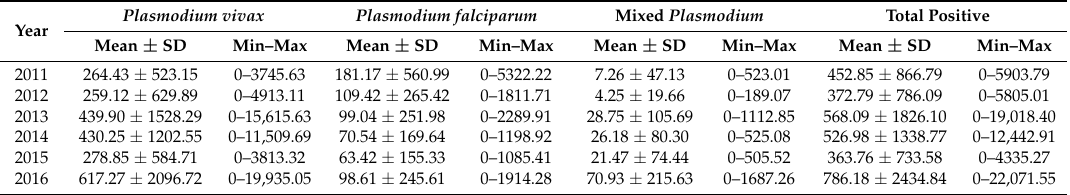
Table 1. Summary of descriptive statistics of malaria incidence rate (per 100,000) by type at the district level in Pakistan,